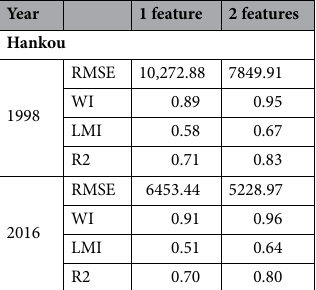
Table 5. Comparison of criteria with different features in Hankou